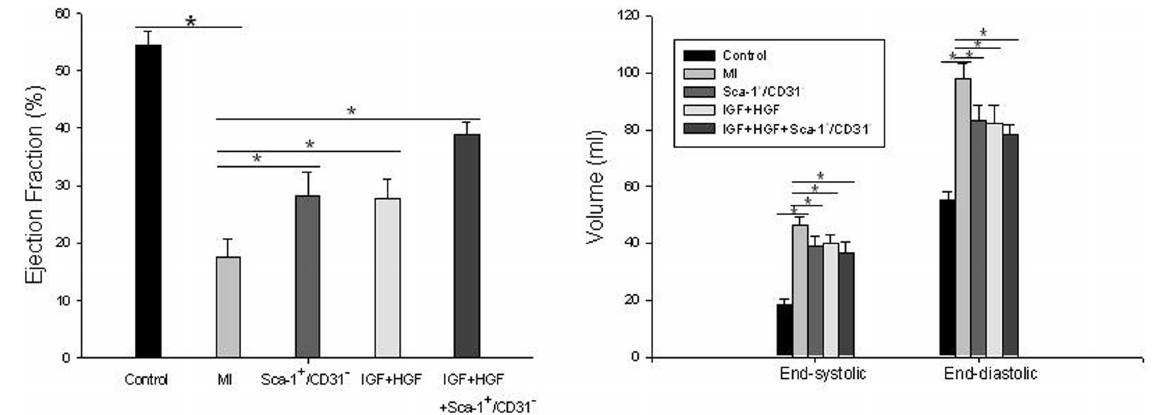
Figure 1. Effects of interventions on LV ejection function and geometry. ( A ) . Ejection fraction (n=9; P , 0.01 vs MI). ( B ) . LV end-systolic and end-diastolic volume (n=9, P , 0.05 vs MI). Data are presented as mean + / 2 SEM.